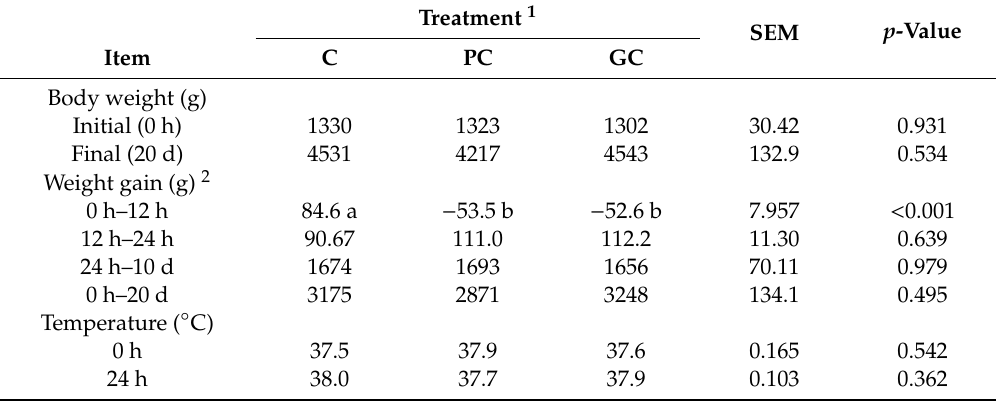
Body weight, weight gain, and rectal temperature of piglets across the di ff erent experimental treatments. Treatment